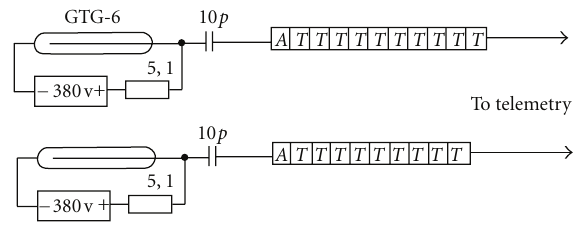
Figure 2: Block diagram of detectors and electronics placed onboard the second Soviet satellite. A : amplifier of the signal from counter, T : trigger of the reducer of count rate.